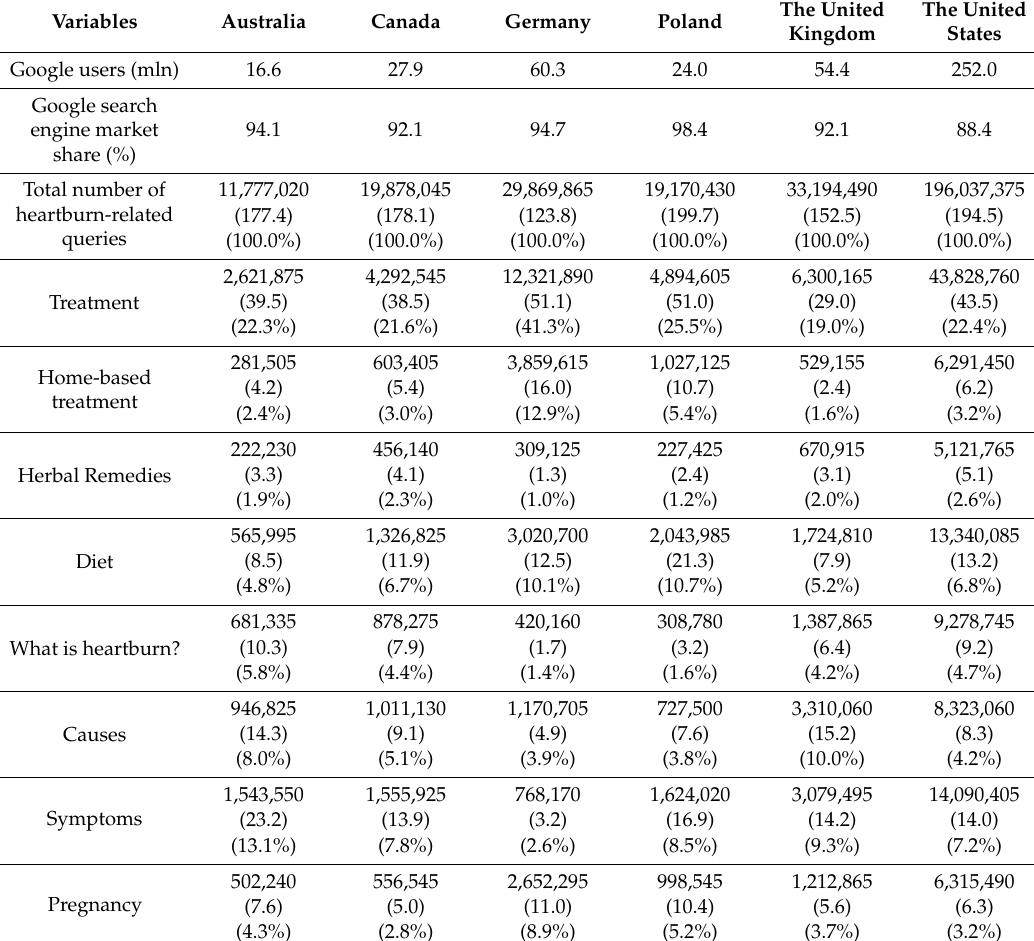
Table 1. Comparison between the analyzed countries regarding heartburn-related searches from June 2015 to May